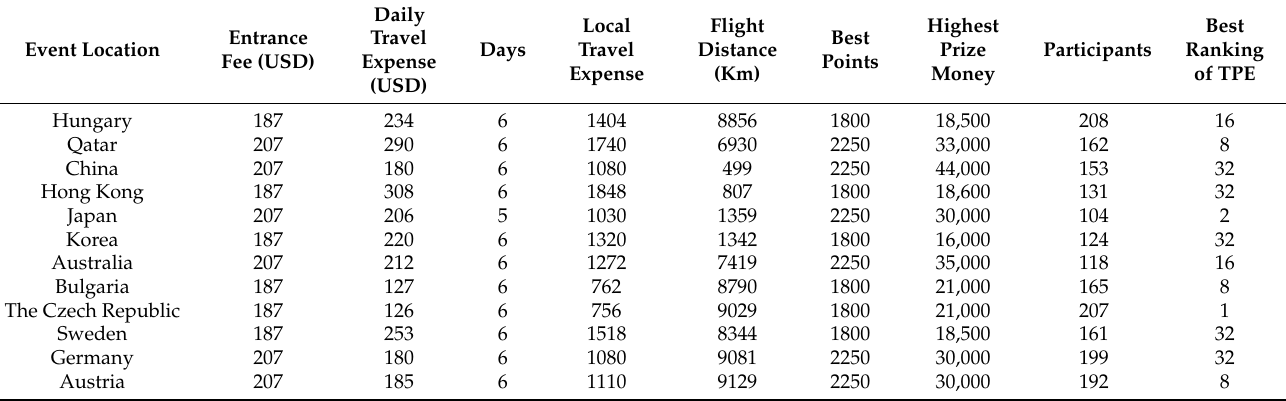
Table 3. Summary of 2019 ITTF World Tour game